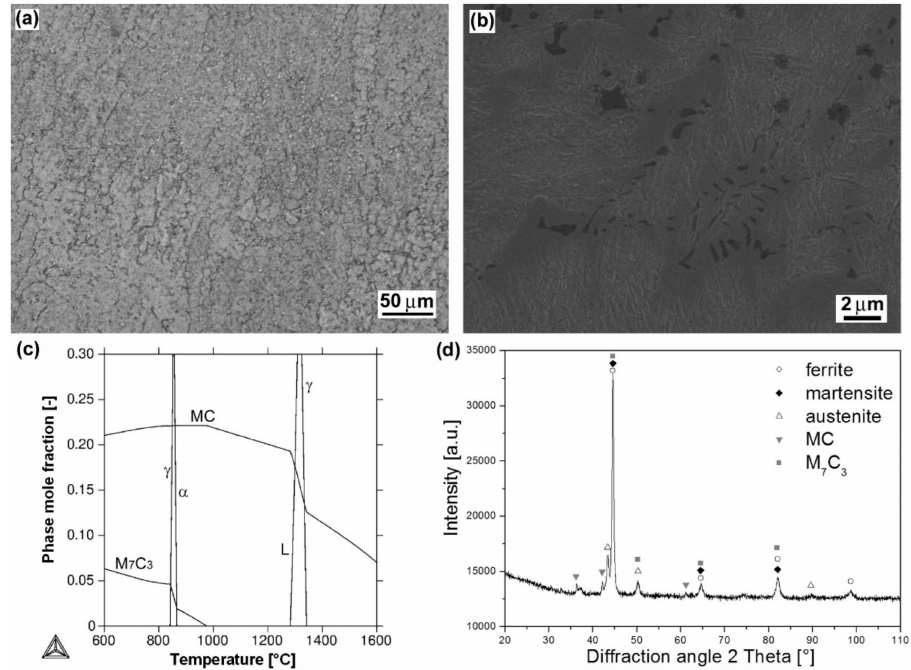
Figure 6. Characterization of “Weartrode 62” hardfacing: overall microstructure visualized by LOM ( a ); detailed microstructure visualized by SEM ( b ); thermodynamic calculation of phase composition depending on temperature ( c ); XRD-pattern representing experimentally determined phase composition ( d